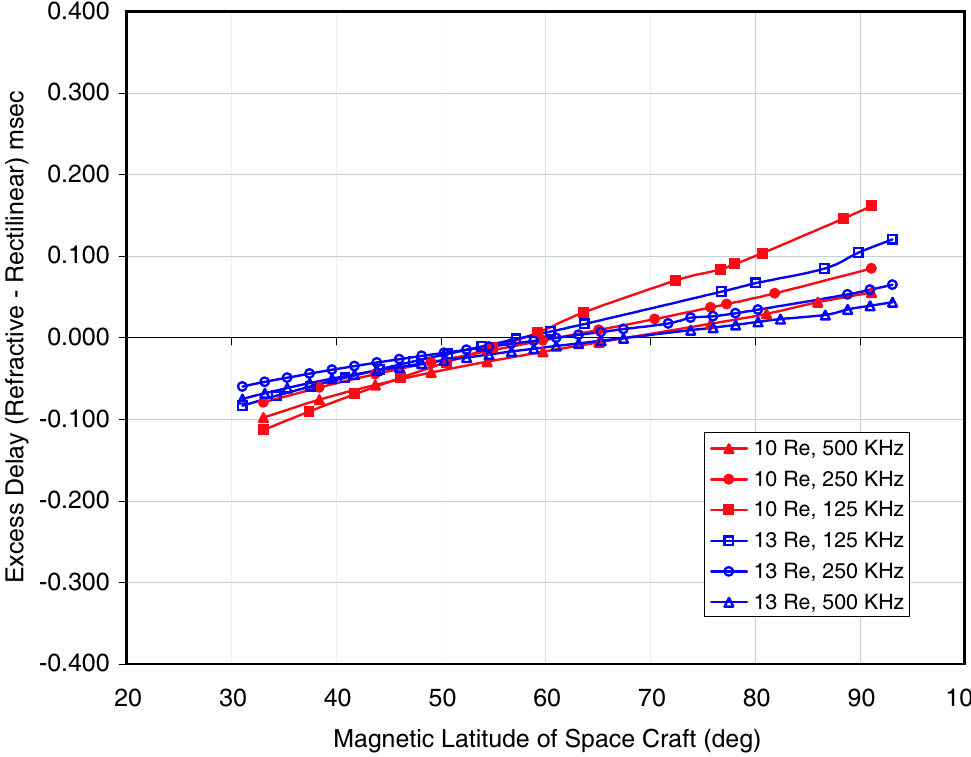
Fig. 5. Excess delay versus spacecraft magnetic latitude for AKR source-spacecraft distances of 10 R E (red lines) and 13 R E (blue lines) and frequencies of 125kHz ( 4 ), 250kHz ( ◦ ), and 500kHz ( (cid:3)